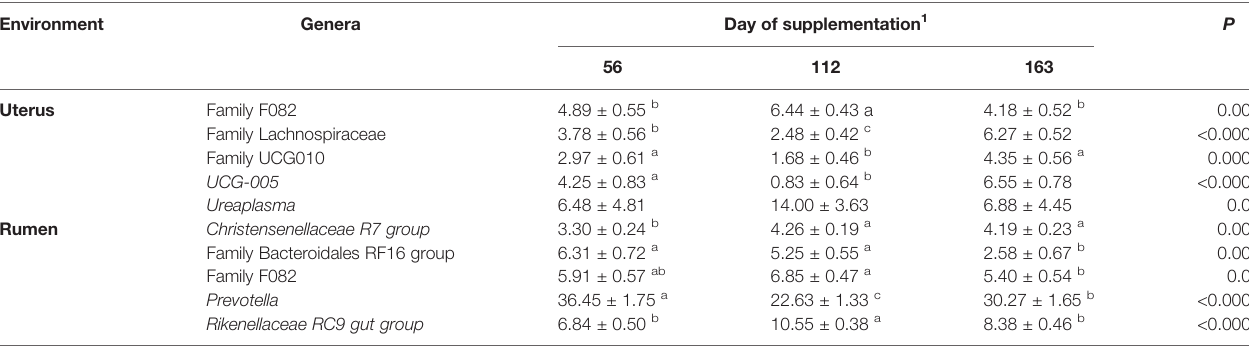
TABLE 5 | Top 5 most abundant bacterial genera in the uterus and rumen impacted by day of supplementation.